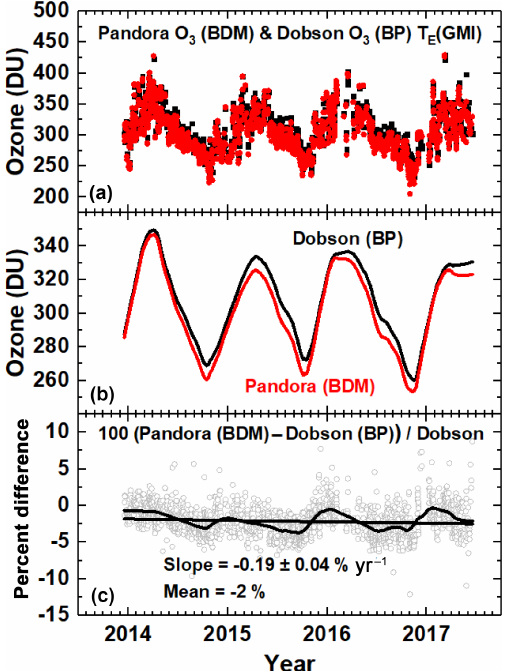
Figure 2. (a) shows the retrieved ozone time series (Decem- ber 2013–June 2017) for Pandora (red) and Dobson (black). (b) shows a Lowess (0.1) fit to the each time series. (c) shows the percent difference, a linear least-squares fit, and a Lowess (0.1) fit showing seasonal